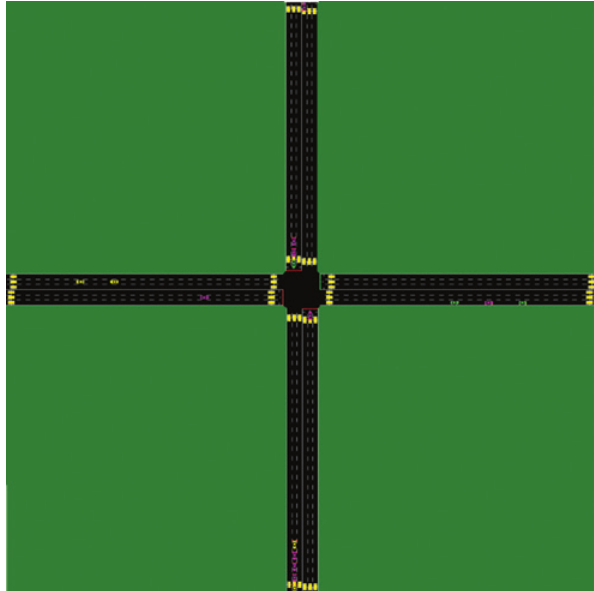
Figure 3: Intersection Configuration with Detectors in Each